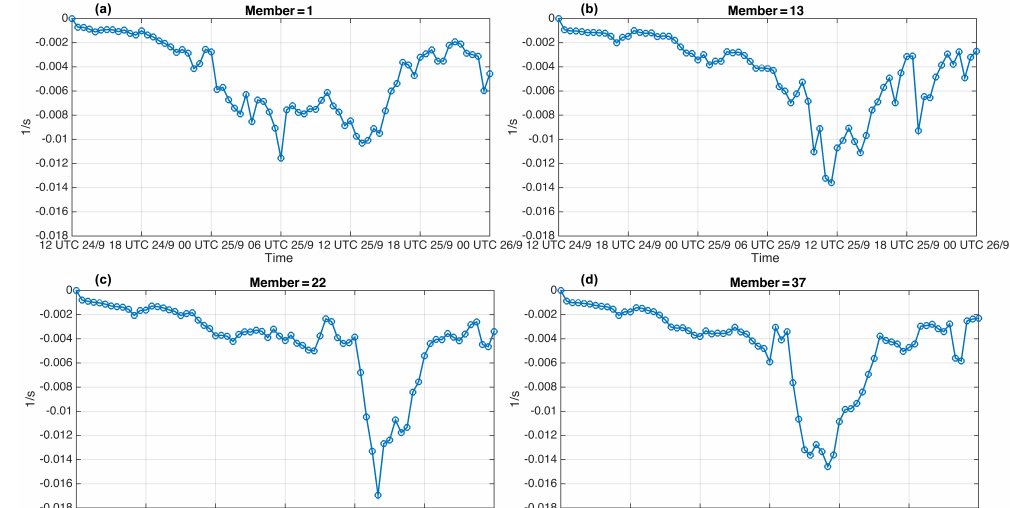
Figure 9. Minimum divergence time series (1/s) for members 1, 13, 22 and 37.